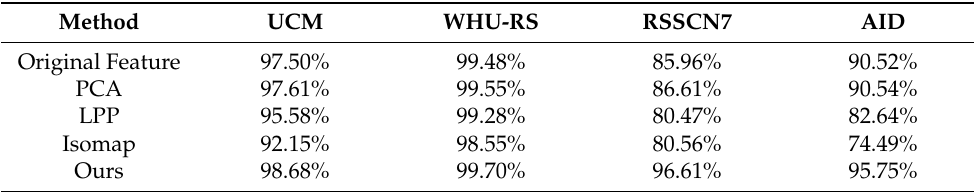
Table 3. Performance comparison of feature transform network and other dimensionality reduction methods.